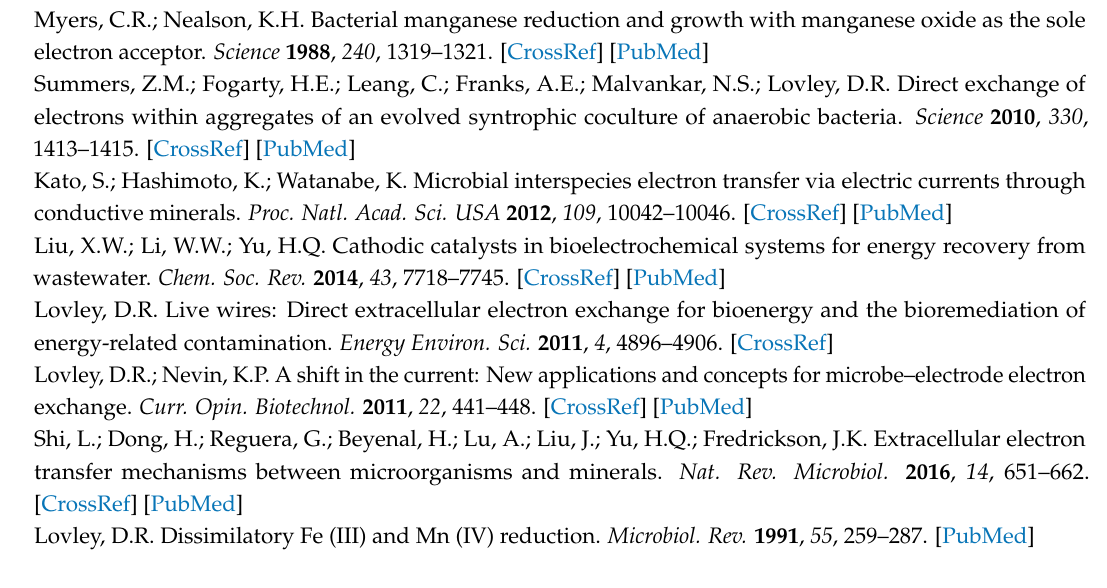
Figure S1: (a) Light microscopy picture of bio-photoanode; (b) ESEM picture of bio-photoanode, Figure S2: Cyclic voltammetry results of the supernatant from live cell culture and fresh LBNS, Figure S3: (a) Pyocyanin in live cell culture; (b) Liquid-liquid extraction for pyocyanin by CHCl 3 ; (c) Liquid–liquid extraction for pyocyanin by HCl, Figure S4: SERS spectra of pyocyanin isolated from centrifuged supernatant of live cell